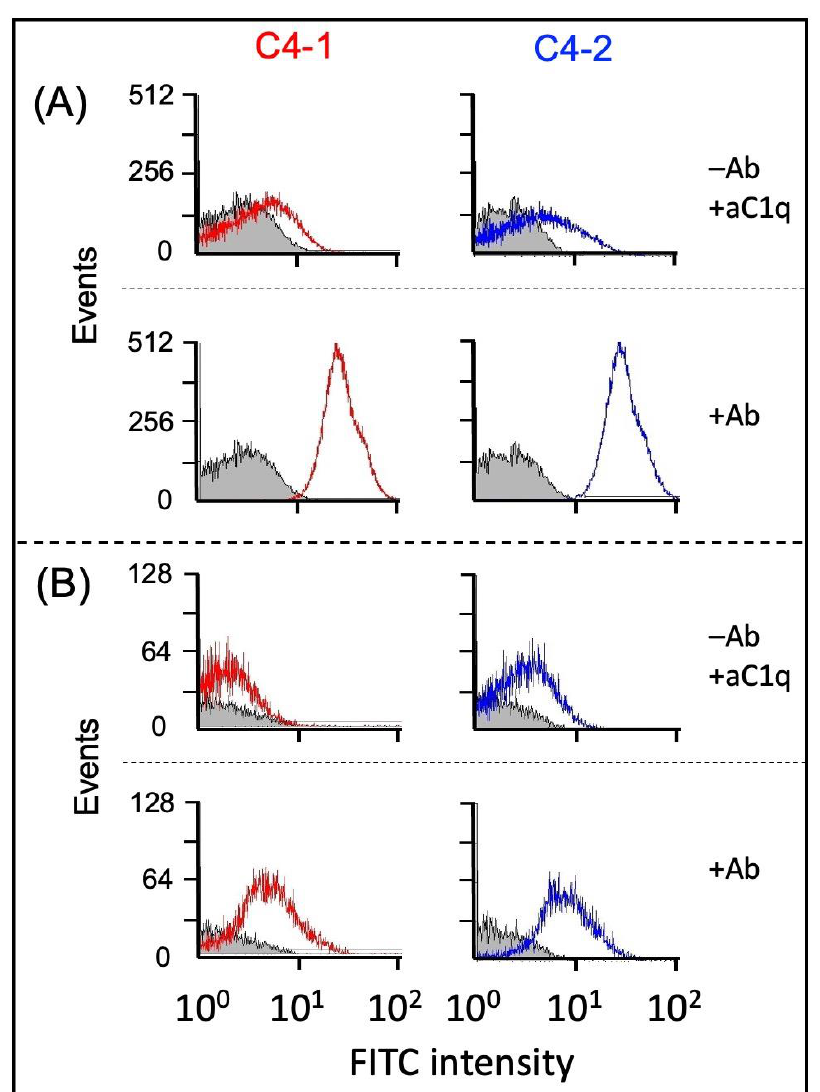
Figure 5. Deposition of C4-1 and C4-2 on bacterial targets, A. hydrophila ( A ) and S. aureus ( B ), assayed via flow cytometry. Signals of C4-1, C4-2, and negative control are shown in red, blue and gray, respectively. Non-sensitized (−Ab) bacteria were incubated with serum in the presence of anti-carp C1q A-chain (aC1q) to selectively activate the lectin pathway, and sensitized bacteria (+Ab) were employed to allow activation through the classical and lectin pathways.